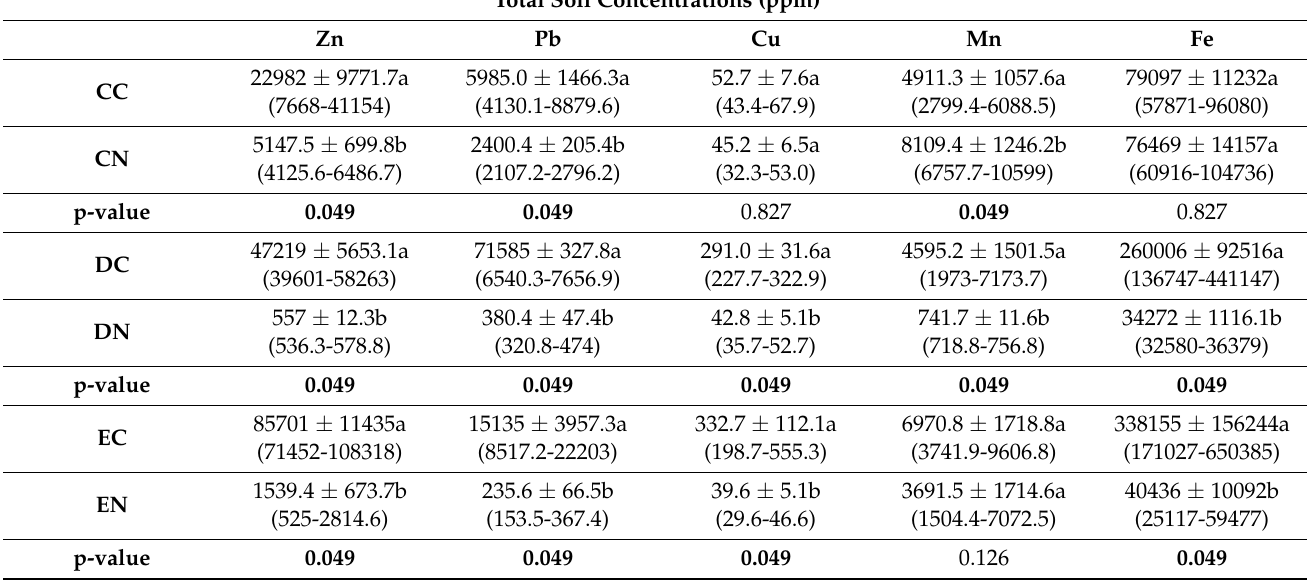
Table 1. Total trace-metal concentrations in contaminated and uncontaminated soils. The mean ± SE values are shown together with minimum and maximum values in brackets. The non-parametric Kruskal–Wallis test was applied. Different letters indicate significant differences at a significance level < 0.05 within the same trace element and plant